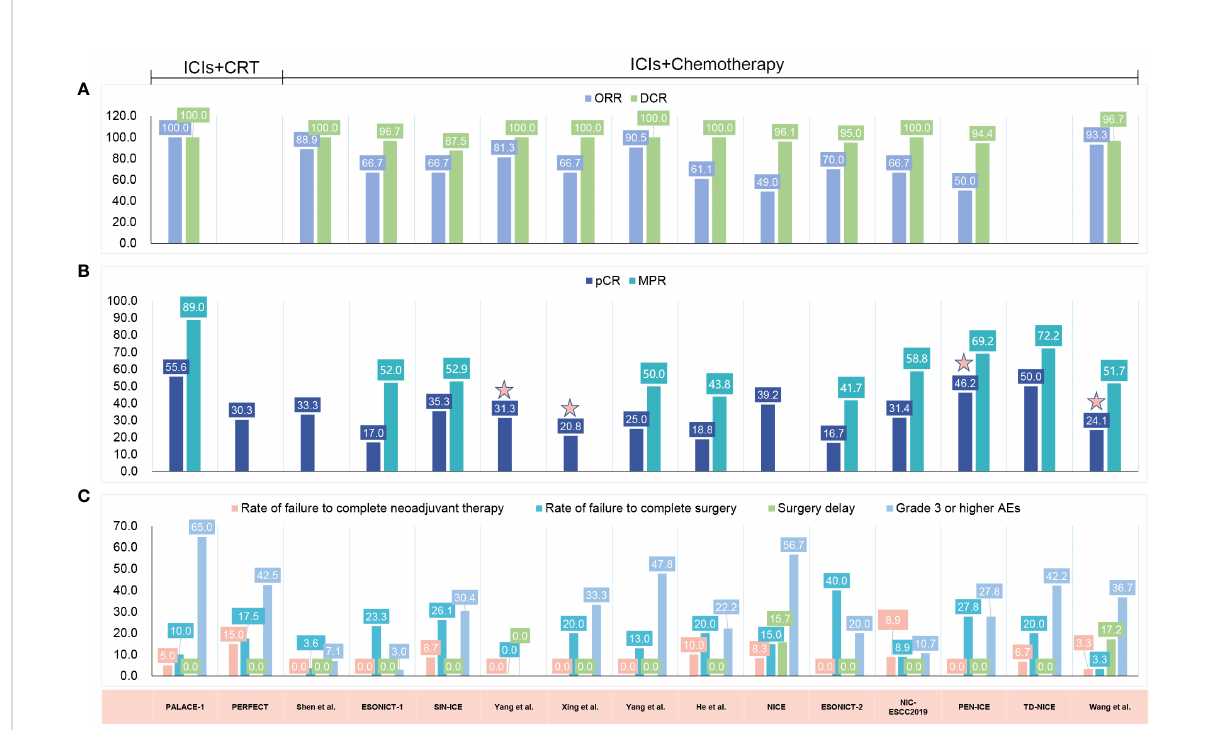
FIGURE 3 Published clinical studies on immune checkpoint inhibitor (ICI) neoadjuvant therapy in resectable esophageal cancer (EC). (A) The radiologic response. (B) The pathological response. (C) The safety results. ICIs, immune checkpoint inhibitors; CRT, chemoradiotherapy; ORR,